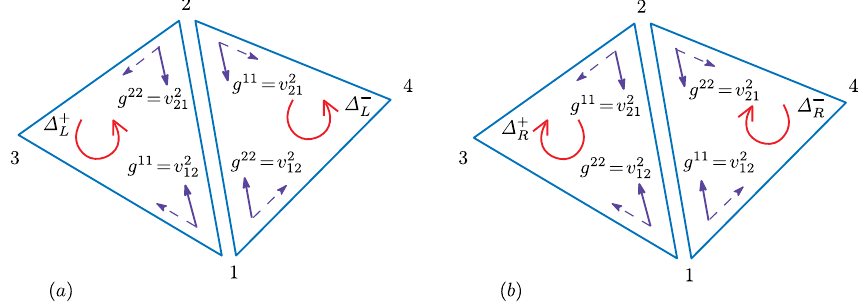
Figure 6. Two of four possible combinations of triangles ∆ + and ∆ − and ( b ) the inverted triangles ∆ + L metric g ab are given by v 2